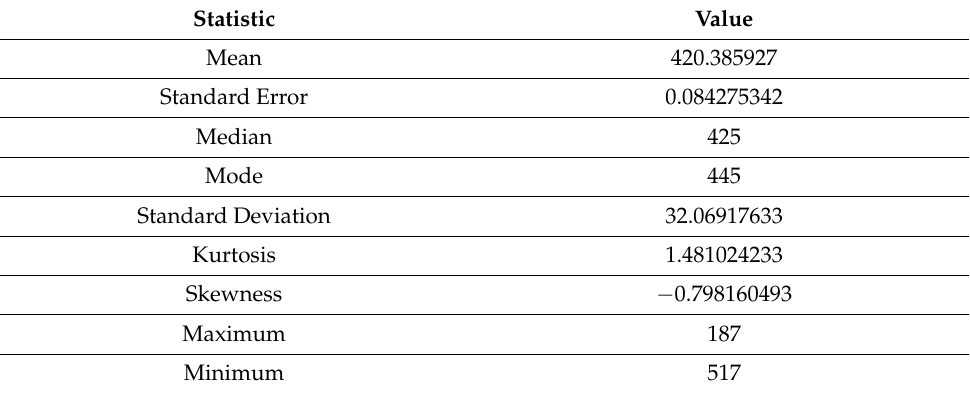
Table 1. Descriptive statistics for the RSSI measurements from the 30 November 2019 to the 27